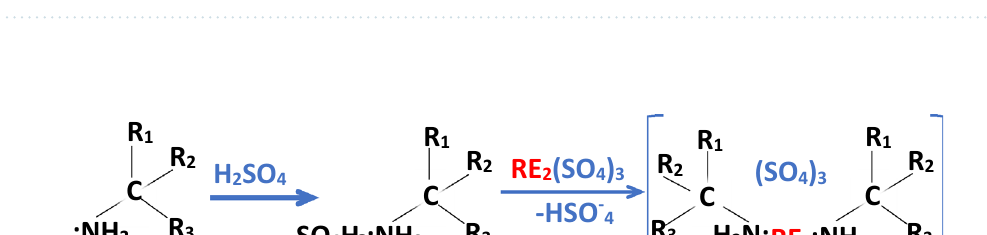
Table 1. Elemental composition of the monazite leachate determined by the ICP-AES